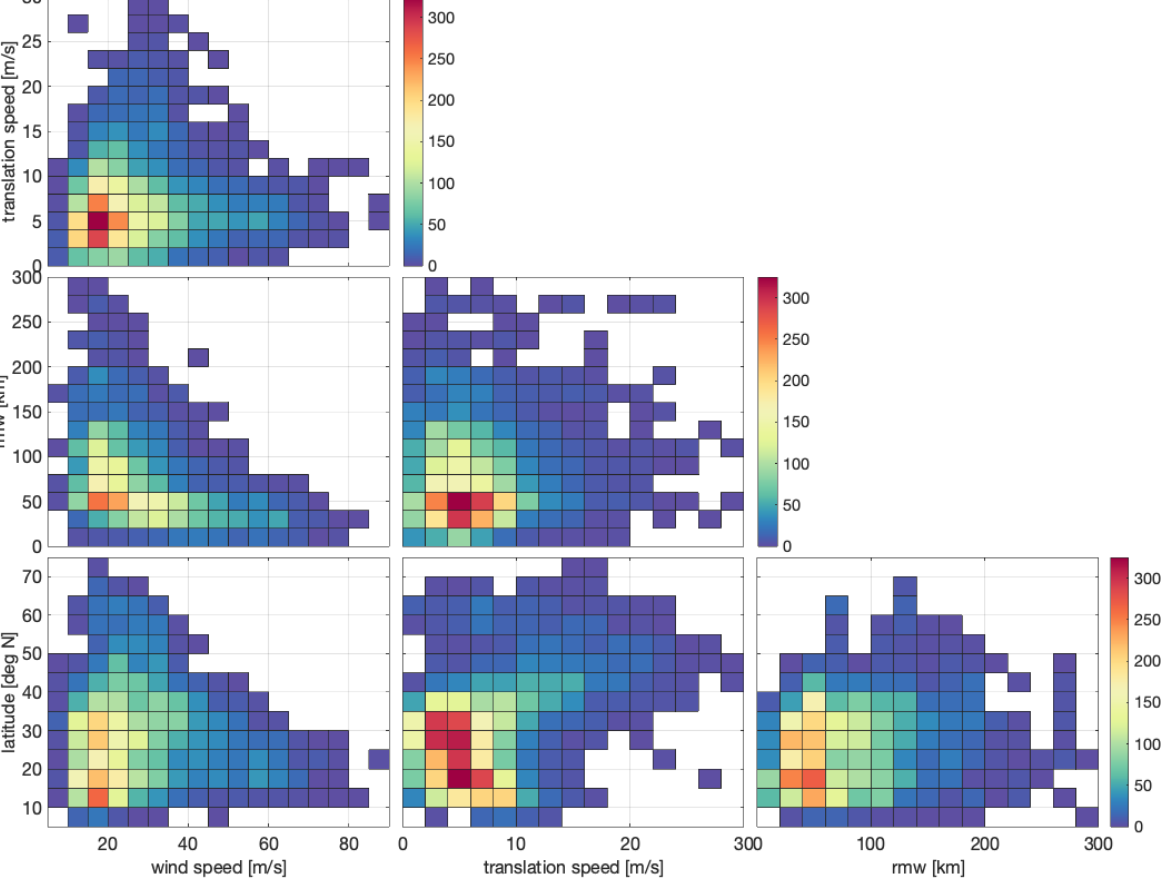
Figure 20. Joint distributions of LPS attributes. From left to right is wind speed, translation speed, and radius or maximum winds. From top to bottom is translation speed, radius of maximum winds, and latitude. Note that the top left figure is the same as Figure